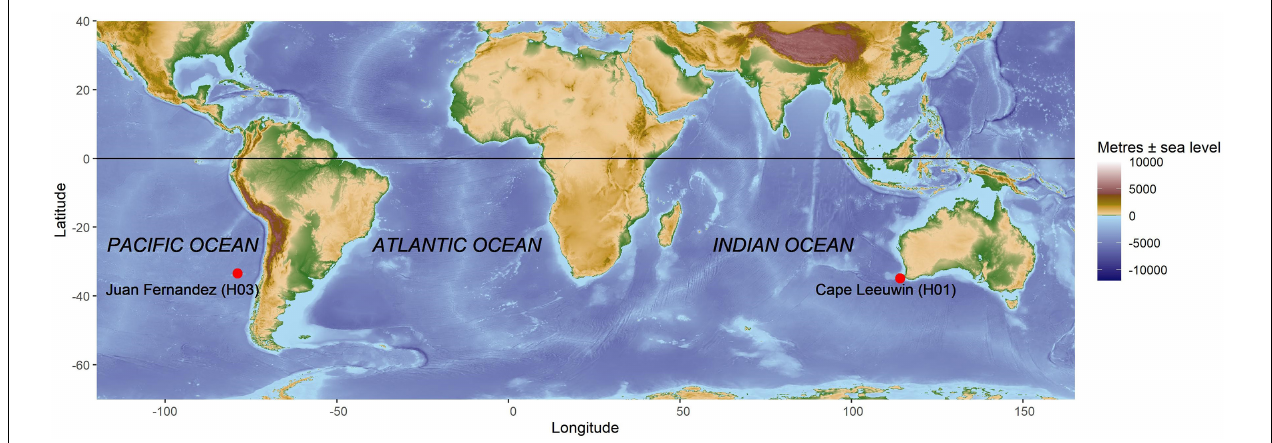
FIGURE 1 | Locations of the two hydroacoustic stations indicated by the red circles. Cape Leeuwin (H01) is located off the southwest corner of Western Australia in the Southeast Indian Ocean and Juan Fernández (H03) is located off the coast of central Chile in the Southeast Pacific